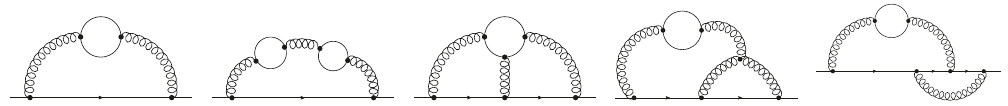
and Z OS . Straight and curly lines m 2